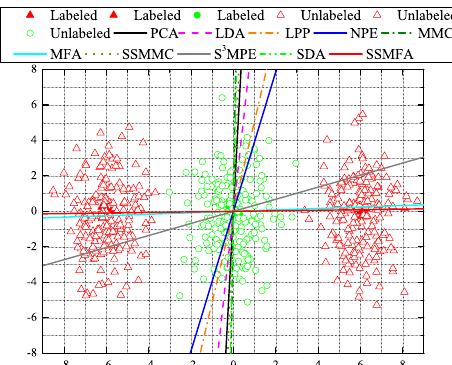
Figure 1: The optimal projecting directions of different methods on the synthetic data. The circles and triangles are the data sam- ples and the filled or unfilled symbols are the labeled or unlabeled samples; solid and dashed lines denote 1-dimensional embedding spaces found by different methods, respectively (onto which data samples will be projected)